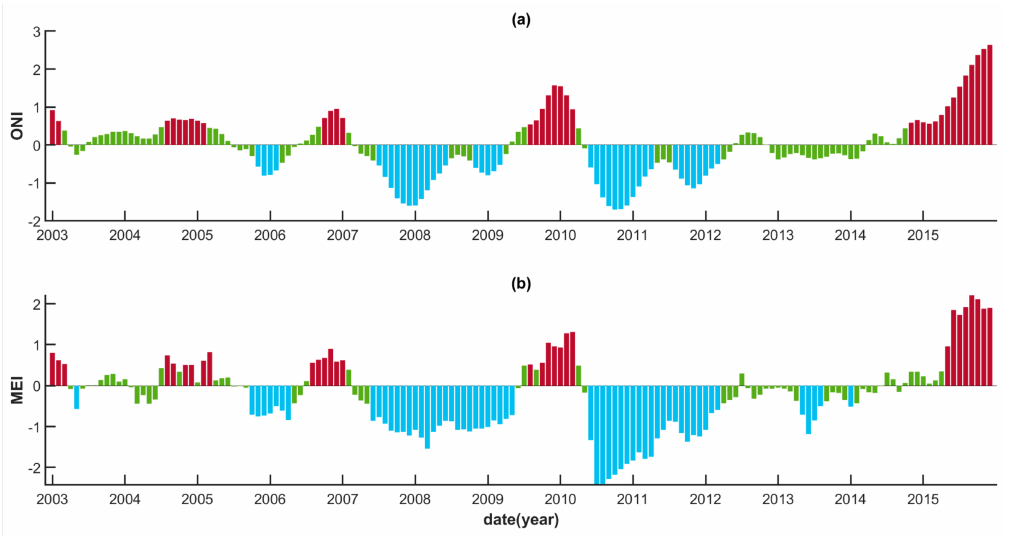
Figure 3. The monthly time series of ( a ) ONI and ( b ) MEI. Green, blue, and red bars represent the neutral parts, the cold phase (La Niña event), and the warm phase (El Niño event), respectively.